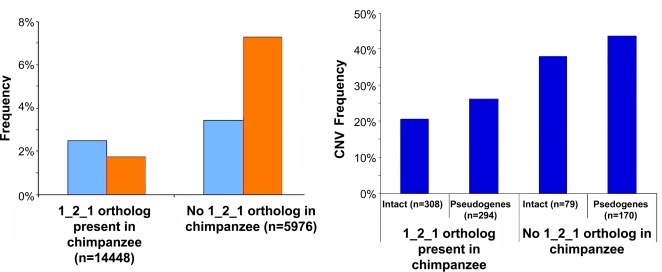
CNVs preferentially affect ORs lacking unambiguous one-to-one orthologs in the chimpanzee genome.A) Gains and losses of OR loci were called using our microarrays (see Methods). Gains are shown in blue; losses in orange; n is the number of total calls considered (24 samples multiplied by the number of genes in each category). OR loci with a one-to-one (“1-2-1”) ortholog in the chimpanzee genome are significantly (Pvalue<0.001; Mann-Whitney U test) less often affected by CNVs than loci lacking a 1-2-1 ortholog. B) Frequencies of CNV loci are given separately for intact OR genes and pseudogenes in each of the evolutionary classes. “Frequency”: relative frequency of being called a CNV for a set.